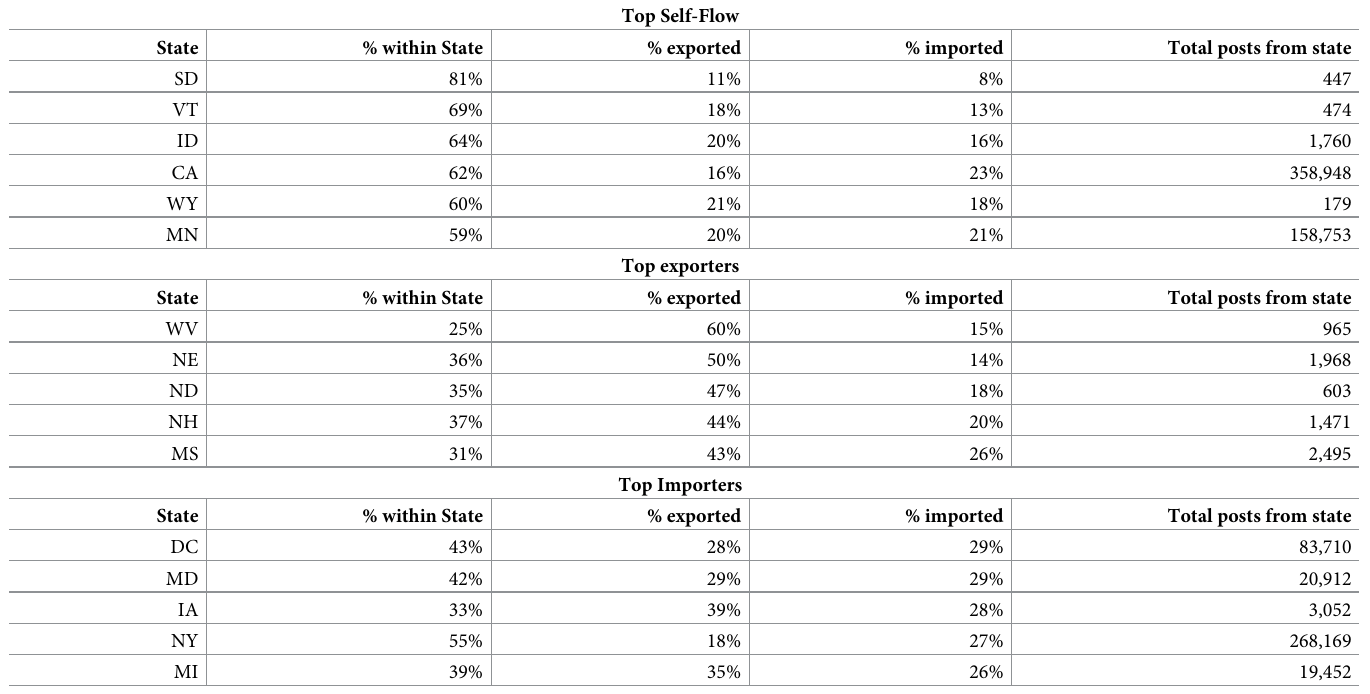
Table 3. Interstate network structure and proportion of posts seen within-state, exported to other states, and imported from other states. Top